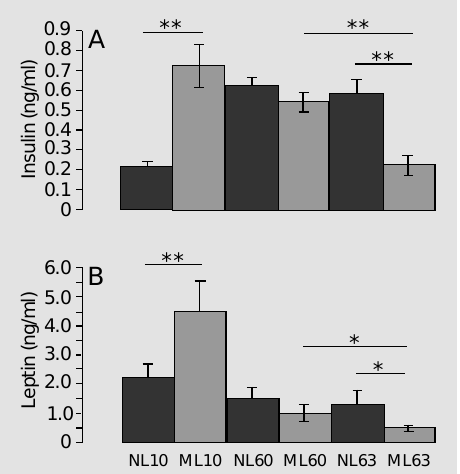
Figure 2. Animal body weight (upper panel) and food intake (lower panel) of rats from dams normally nourished (NL) or malnourished (ML) with a protein-free diet (PFD) during the first 10 days of lactation. At 60 days of age both groups were submitted to a PFD (groups NL* and ML*). Significant differences in animal body weight and food intake were observed between NL* and ML* at 63 days (3 days of PFD). The arrows indicate the time (age) when independent groups were sacrificed to collect blood for insulin and leptin measurements. Data are reported as means ± SEM (N = 6).